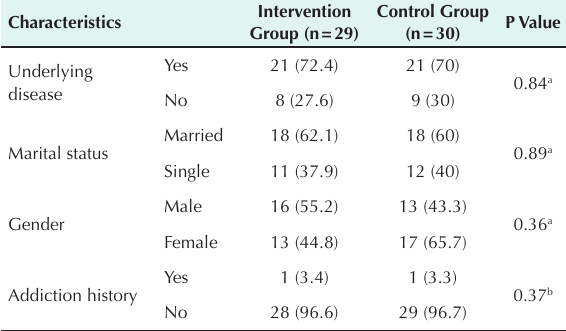
Table 1. Demographic and Clinical Characteristics of Participants